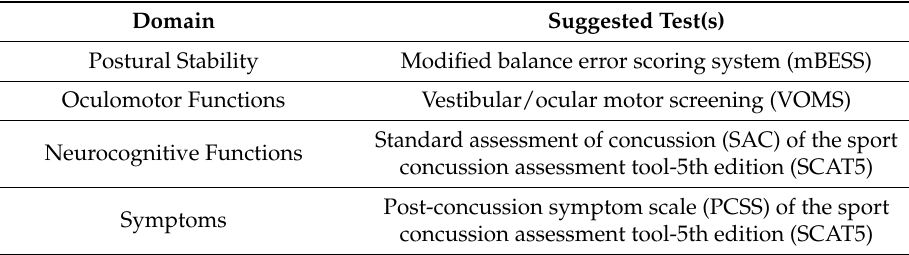
Table 1. Recommended assessment and suggested tests in the acute evaluation of sport-related concussion